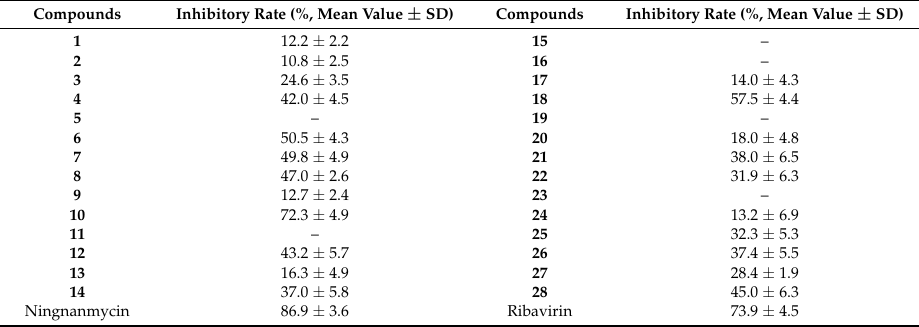
Table 2. Inhibitory activity against Tobacco mosaic virus (TMV) of 1 – 28